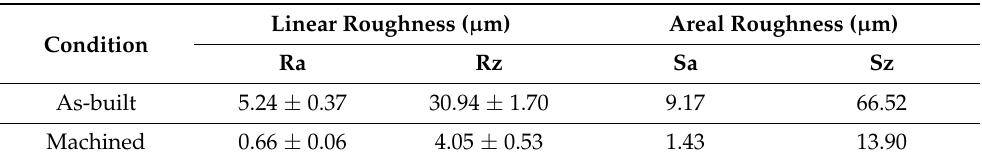
Table 3. Measured linear and areal roughness values from the vertical as-built and machined surfaces of IN718 specimens.